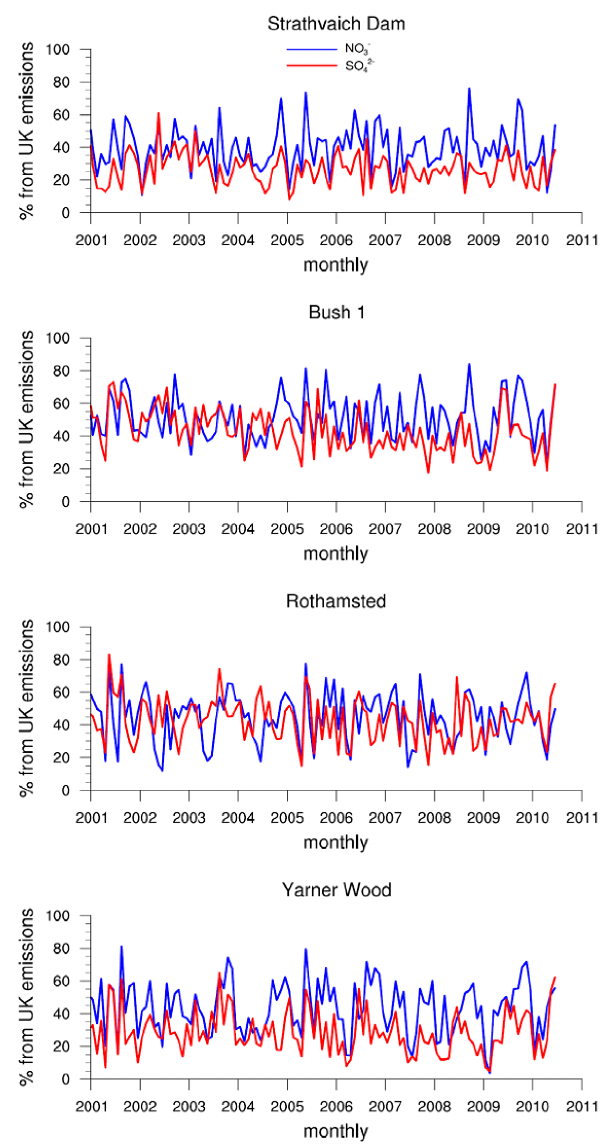
Figure 10. Modelled monthly average proportions of NO − line) and SO 2 − (red line) derived from UK precursor emissions, 4 for four sites in the UK for the decade 2001–2010 (calculated as [100×(Base − no UK emi)/Base] between the base simulation and the simulation with zero UK